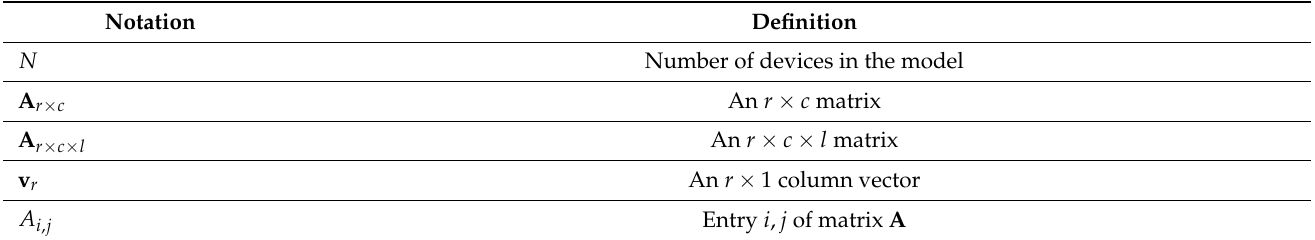
Table 1 introduces the notation used through this document. Table 1.